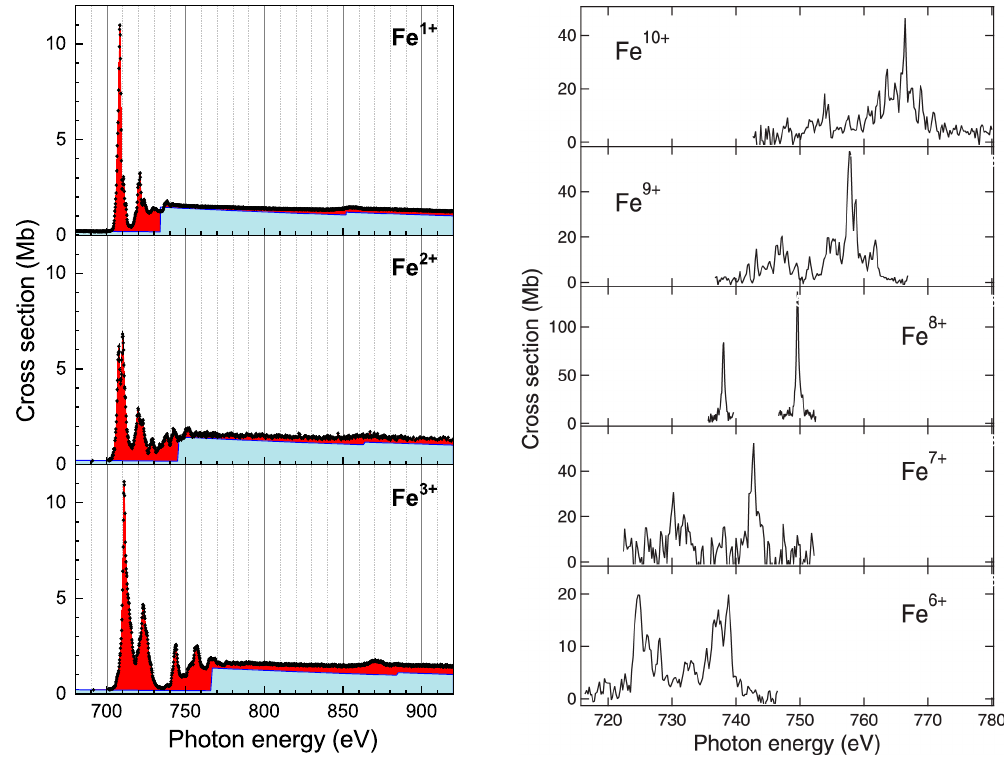
Figure 4. Left panels: Experimental cross sections (symbols) from PIPE for photoabsorption of Fe + [37], Fe 2 + [38], and Fe 3 + [39]. The uncertainty of the experimental energy scale amounts ± 0.2 eV. The light-shaded full curves are theoretical cross sections provided by Verner et al. [51]. The steps in the theoretical cross sections occur at the computed thresholds for direct ionization of a 2 p or a 2 s electron. The photoionization resonances that dominate the experimental spectra below the 2 p thresholds were not considered in the theoretical calculations. Right panels: Experimental cross sections for single ionization of Fe 6 + –Fe 10 + ions measured at SOLEIL [46] (reproduced by permission of the